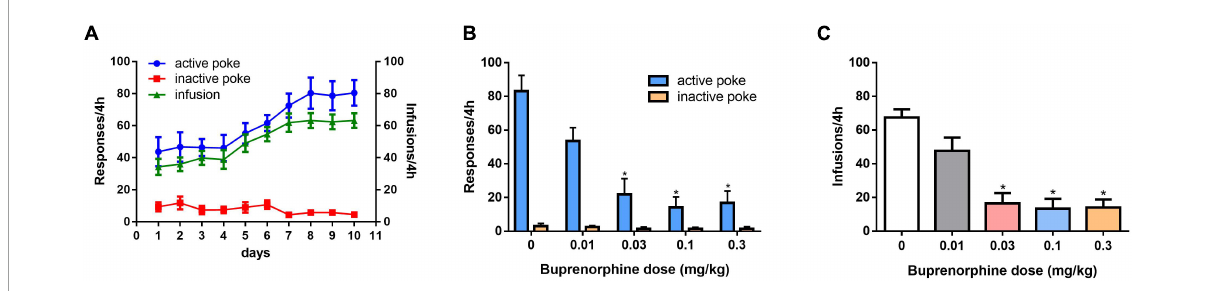
FIGURE1 Effects of pretreatment with buprenorphine on methamphetamine reinforcement in rats. Values are presented as means ± SEM. (A) The acquisition of METH self-administration at dose of 0.05 mg/kg under FR1 schedule of reinforcement, left Y axis indicates the responses of nose poke and the right Y axis is the infusions. (B) . Buprenorphine inhibited the active responses in a dose-dependent manner on METH self-administration under FR1 schedule. (C) . Buprenorphine inhibited infusions on METH self-administration under FR1 schedule. * P < 0.05 vs. vehicle.